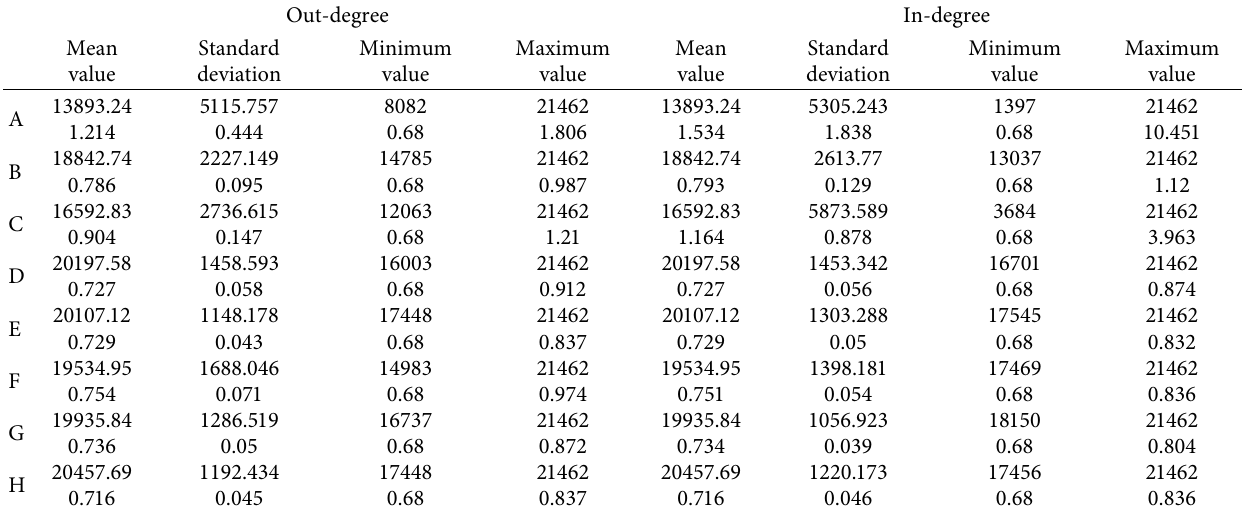
Table 3: The closeness centrality of the society of professional